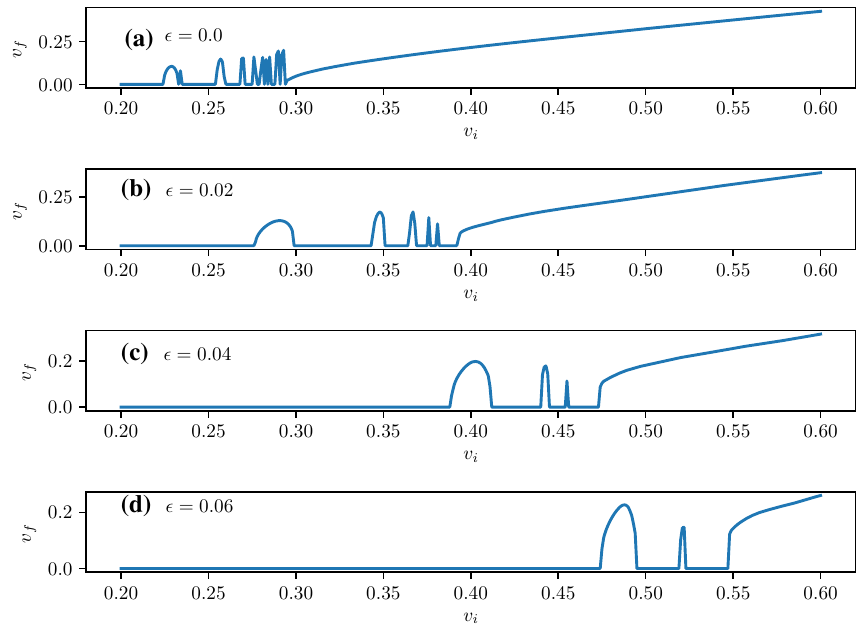
windows where n is the window number. c Plot of the time between the first and second collisions versus the window number n . Parameters in all graphs are (cid:9) = 0 and γ = 2 . 667